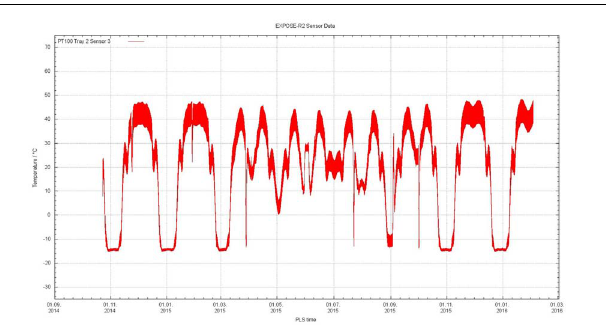
FIGURE 9 | Overview of the EXPOSE-R2 tray temperature profiles for tray 2 temperature sensor 3 and the respective mission period from October 23, 2014 to February 2, 2016 when EXPOSE-R2 was powered and data available. Credit OHB.